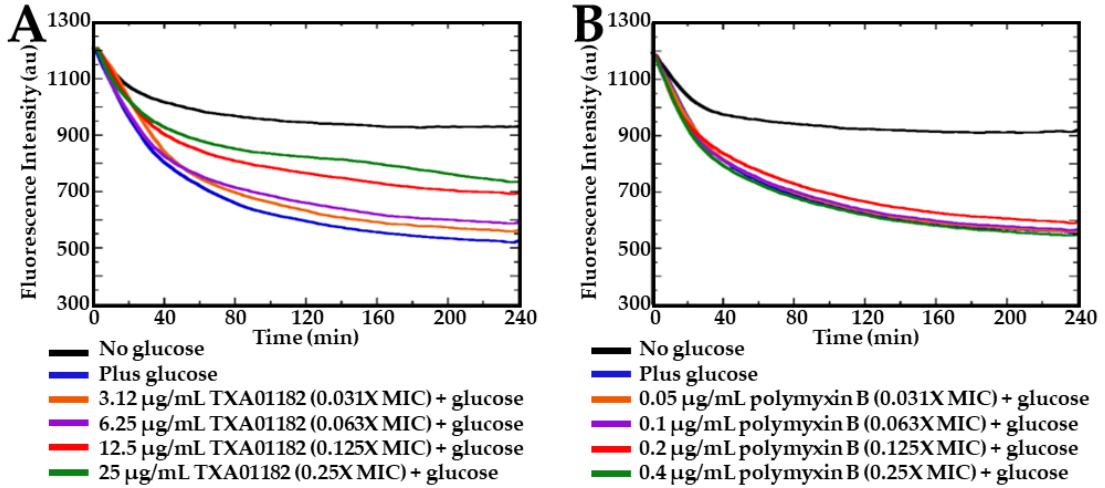
Figure 5. ( A ) TXA01182 concentration-dependent inhibition of EtBr efflux. ( B ) polymyxin B does not inhibit EtBr efflux under the same conditions.